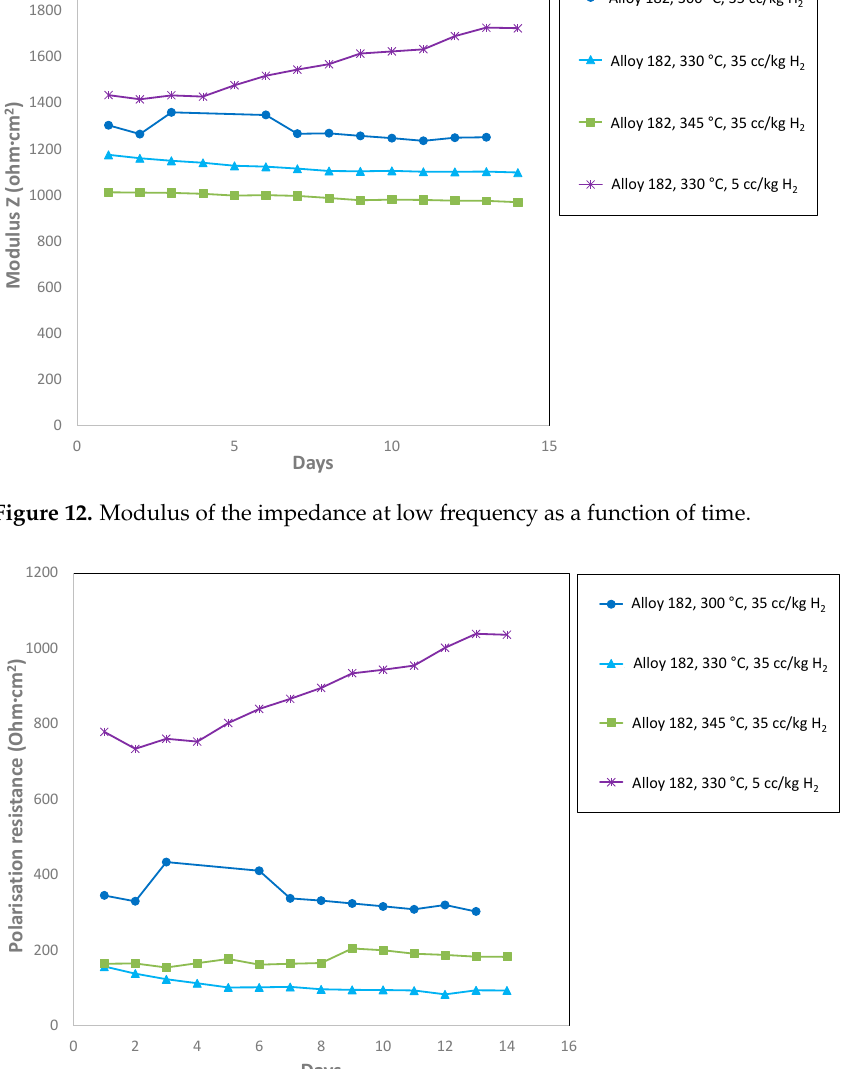
Figure 13. Polarisation resistance as a function of time determined as the difference between the low impedance and the high frequency intersect with the real axis, as a function of time.